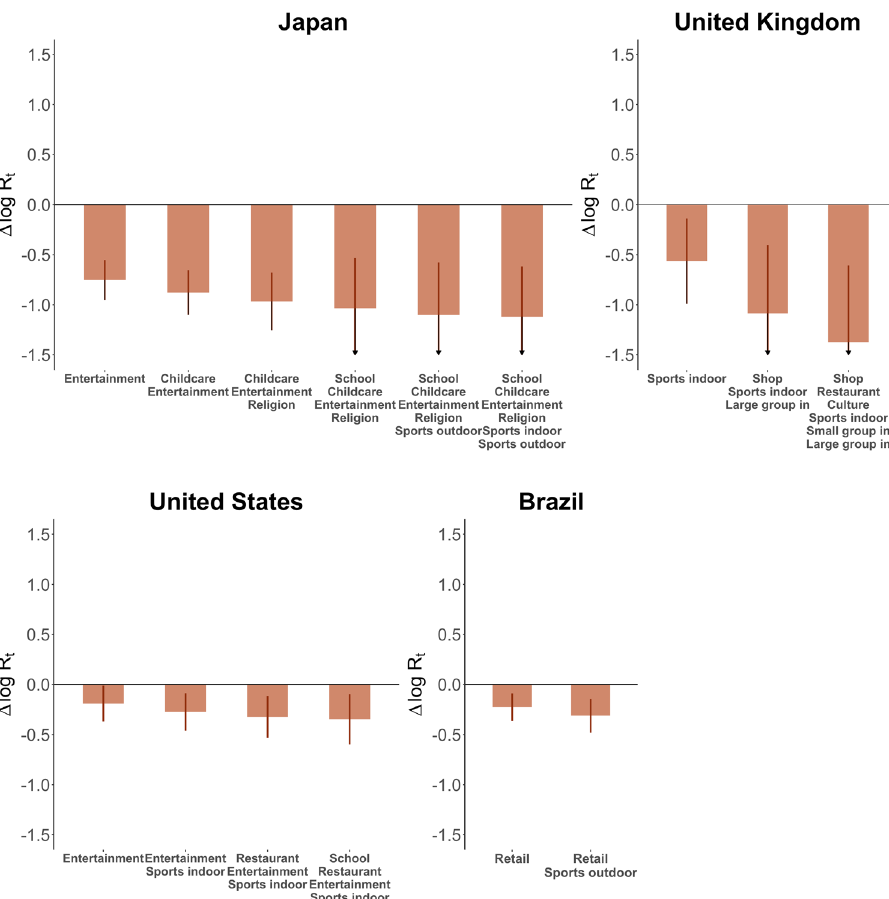
Fig. 3 Maximum joint impacts of closing a number of establishments. We show the maximum impacts that could be achieved by closing a given number of establishment types, till the maximum joint impacts are produced. The error bars represent 95% con fi dence